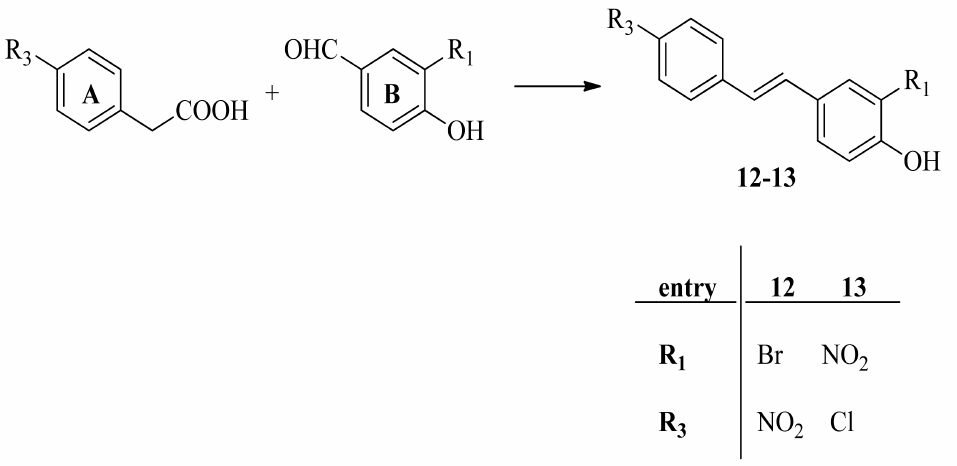
Figure 2. Synthesis of compounds 12 – 13 . Reagents and conditions: 4-hydroxybenzaldehyde (1.0 eq.), aryl acetic acid (1.2 eq.), piperidine (2.5 eq.); 130 ◦ C, 20–23